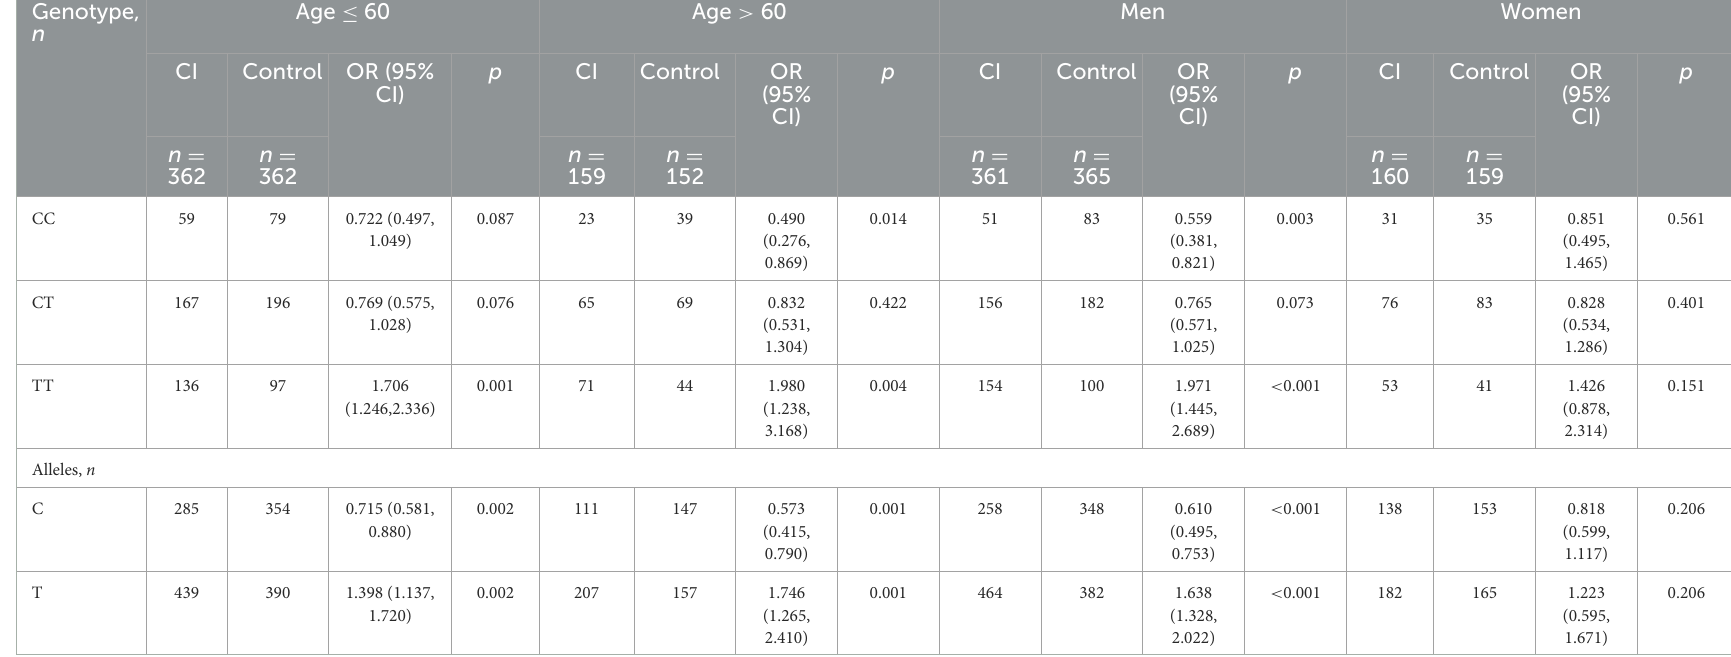
TABLE 4 Stratified analyses of the association between MTHFR C677T polymorphism and risk of CI. Genotype,